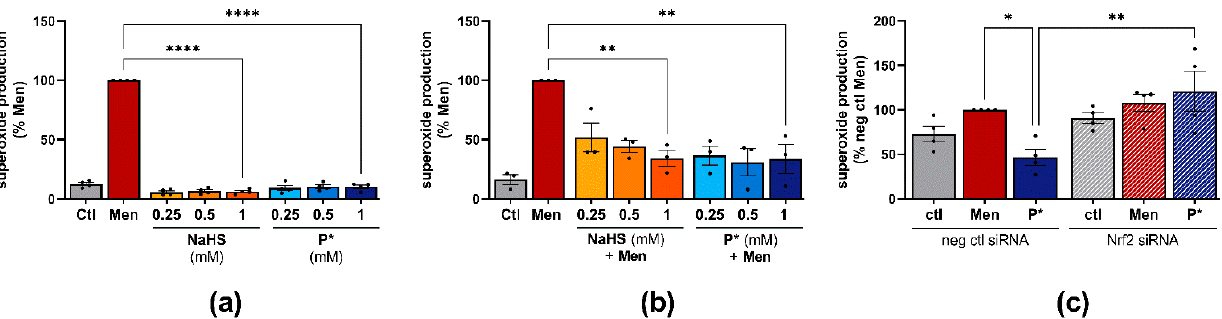
Figure 6. Antioxidative effects of P*. Ctl = untreated cells, representative fluorescence images of superoxide measurement are presented in Supplementary Figures S8 and S9. ( a ) Superoxide production in response to NaHS or P* was measured in ATDC5 cells and normalized to menadione (Men) set to 100%, n = 4, **** p < 0.0001. ( b ) Superoxide production in response to 24 h NaHS or P* followed by 4 h Men (50 µ M), normalized to Men (100%). n = 3, ** p < 0.01. ( c ) ATDC5 cells transfected with Nrf2 (Nrf2 siRNA) or negative control (neg ctl siRNA) siRNA were preincubated with 1 mM P* for 24 h. After 4 h of incubation with Men (50 µM), superoxide production was measured and normalized to neg ctl Men set to 100%, n = 4, * p < 0.05, ** p < 0.01.